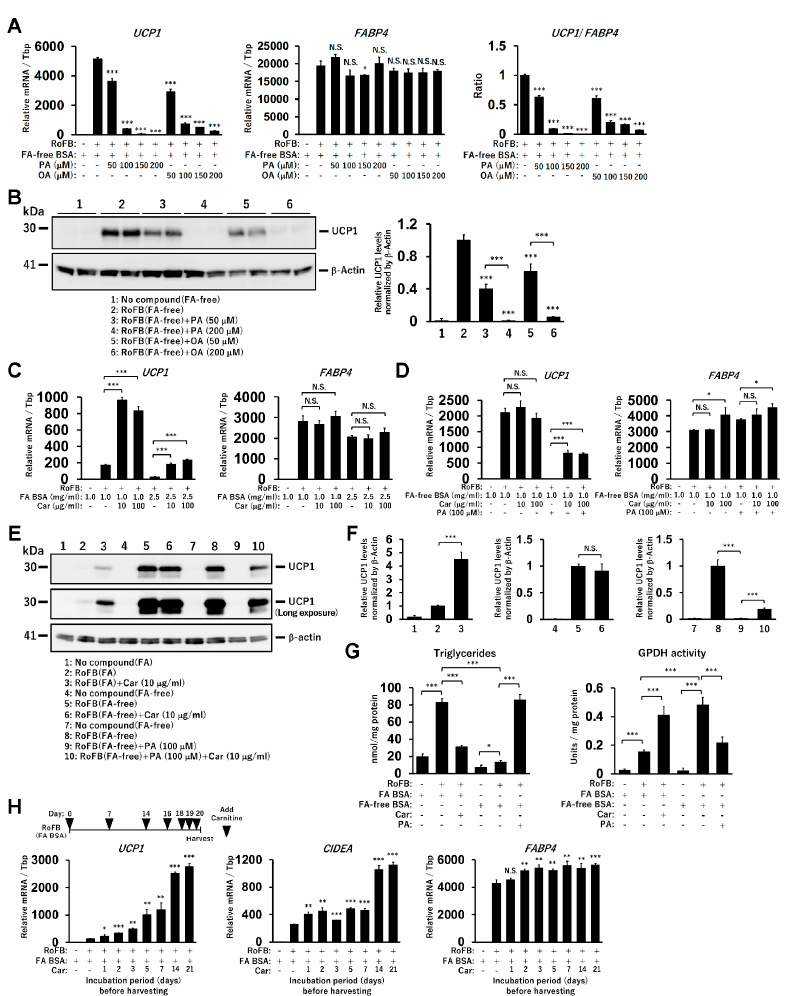
Figure 2. Treatment with FAs and carnitine modulates UCP1 expression in ciBAs. ( A ) The expression of UCP1 and FABP4 mRNA and the ratio were quantified using qRT-PCR in ciBAs treated with either palmitic acid (PA) or oleic acid (OA) at different concentrations as indicated. ( B ) UCP1 protein levels were quantified using immunoblotting. ( C , D ) The expression of UCP1 and FABP4 mRNA was quantified using qRT-PCR in ciBAs treated with carnitine (10 and 100 µ g/mL) and FA BSA ( C ) or FA-free BSA ( D ). ( E ) The UCP1 and β -Actin proteins were immunoblotted in ciBAs converted under different conditions, as indicated. ( F ) The relative UCP1 protein levels were calculated from band intensities shown in Figure S2C. ( G ) Cellular triglyceride content and GPDH activity were measured in ciBAs treated with either carnitine or PA. ( H ) The expression of UCP1 , CIDEA , and FABP4 was measured using qRT-PCR in ciBAs treated with FA BSA and carnitine (10 µ g/mL) for different incubation periods (days), before harvesting the cells on day 21. The illustration represents the timing of the addition of carnitine. Data represent mean ± SD ( n = 3). Student’s t -test: * p < 0.05, ** p < 0.01, *** p < 0.001, N.S.; not